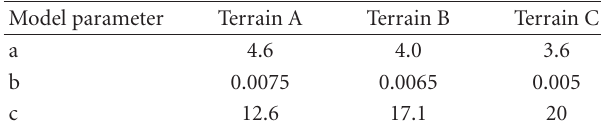
Table 3: Values of